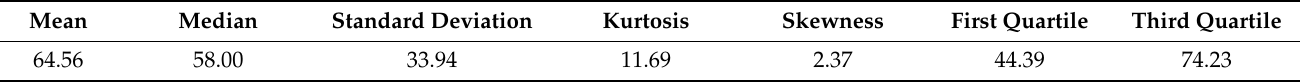
Table 2. Main electricity price statistics in